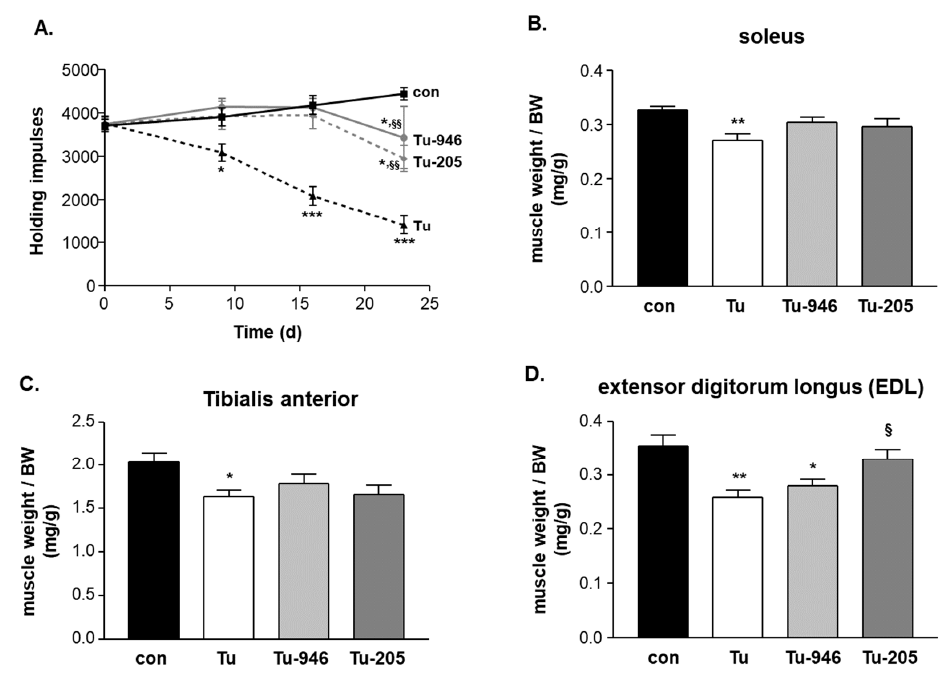
Figure 2. Effect of Myomed-946 and -205 on skeletal muscle weights and wire hang test (WHT) expressed as maximal holding impulses in Tu mice. WHTs indicated progressively falling holding impulses until day 23 in the Tu group. Feeding with Myomed-946 and -205 attenuated this ( A ). Soleus ( B ) tibialis anterior ( C ) and EDL ( D ) muscle weights were determined at day 24 when dissecting the four study groups. Tumor outgrowth lowered muscle weights in all three skeletal muscles types. Feeding with Myomed-946 and -205 attenuated muscle wasting. Values are shown as mean ± standard error of the mean, * p < 0.05, ** p < 0.01 vs. con; § p < 0.05 vs. Tu.